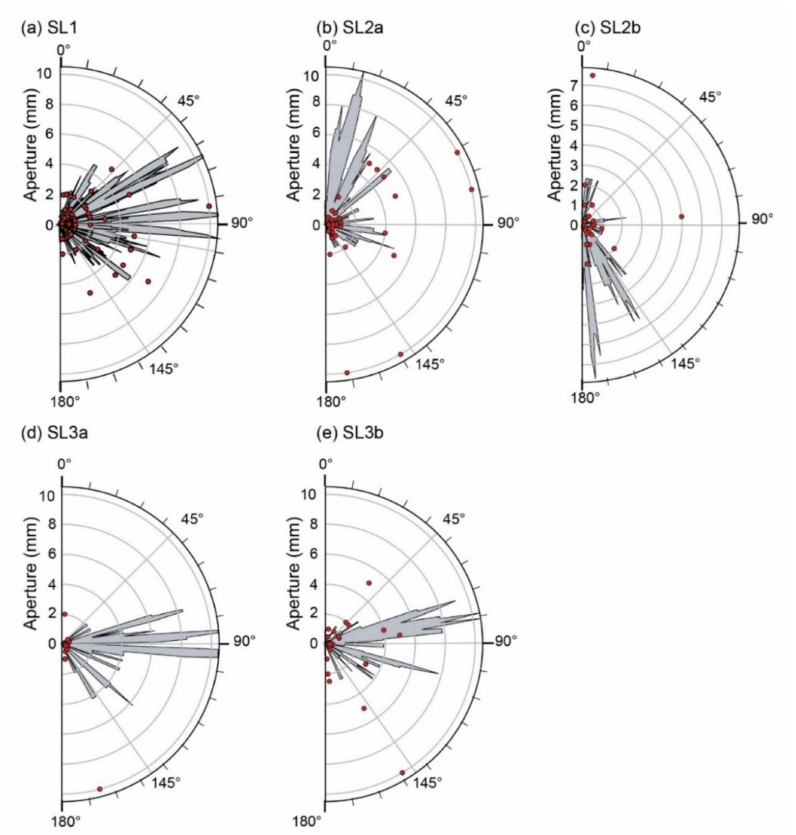
Figure 11. Half circular diagram showing the relation between fracture strike and apertures. ( a ) SL1, ( b ) SL2a, ( c ) SL2b, ( d ) SL3a, and ( e ) SL3b. Apertures from SL4 to SL10 are not available. Rose diagram scaled for mean aperture with classes of 5 ◦ .